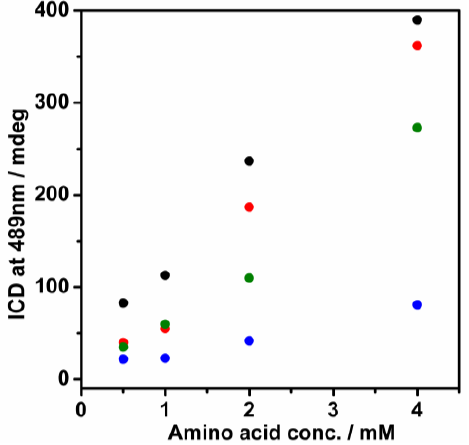
Figure 4. Intensity of the iCD at 489 nm (absolute value) versus the amino acid concentration. Black dots represent Arg; red dots represent Lys; green dots represent His; and, blue dots represent Phe.